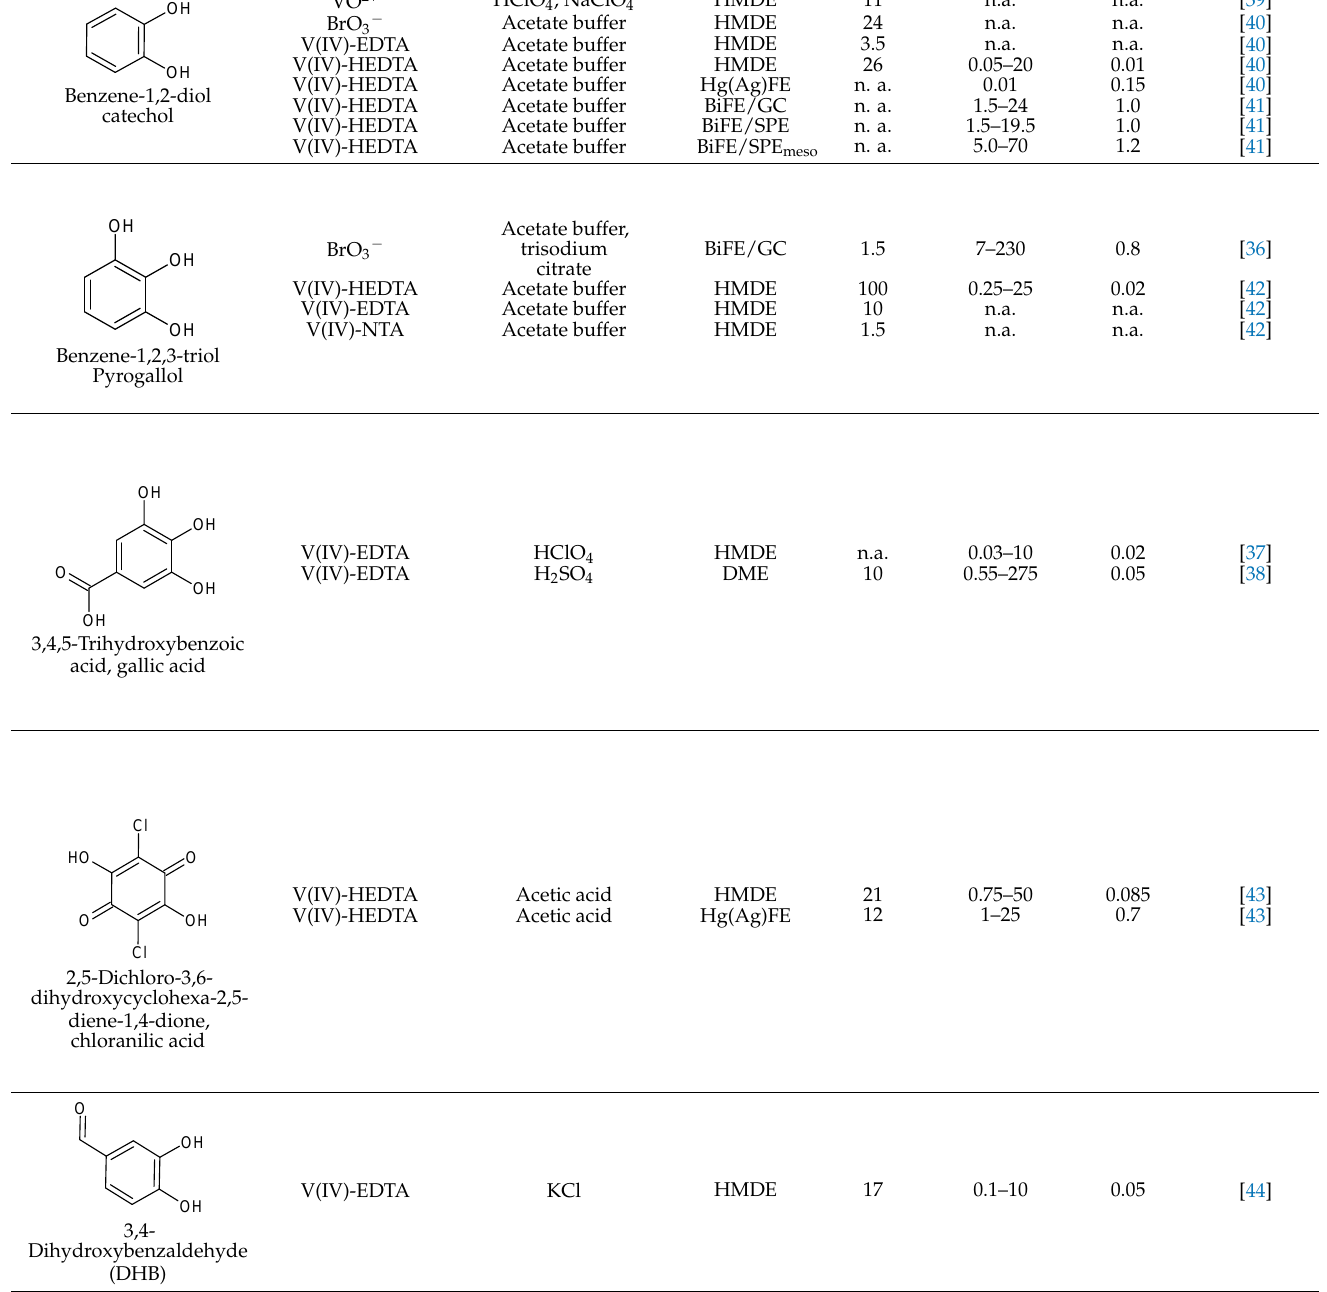
Scheme 1. Mechanism of the electrode processes responsible for the amplification of the Ge(IV) voltametric signal in the presence of gallic acid (L) and oxidant. Table 1. Catalytic systems involving germanium and their properties.